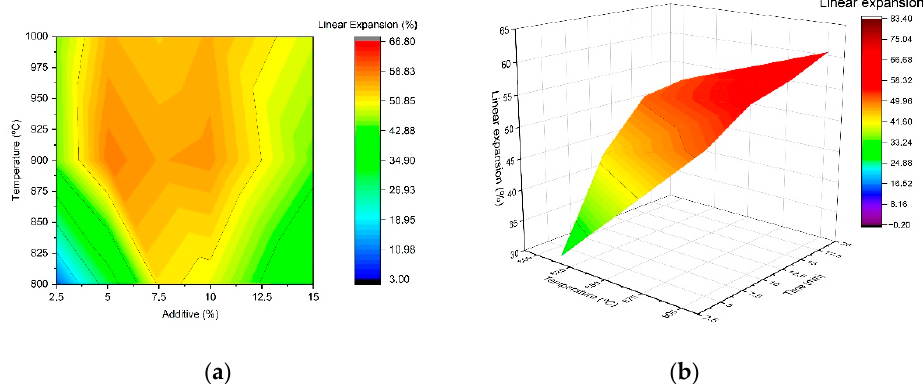
Figure 7. Appearance of the glass lightweight aggregates after the expansion tests performed with different processing parameters on hand–formed pellets.